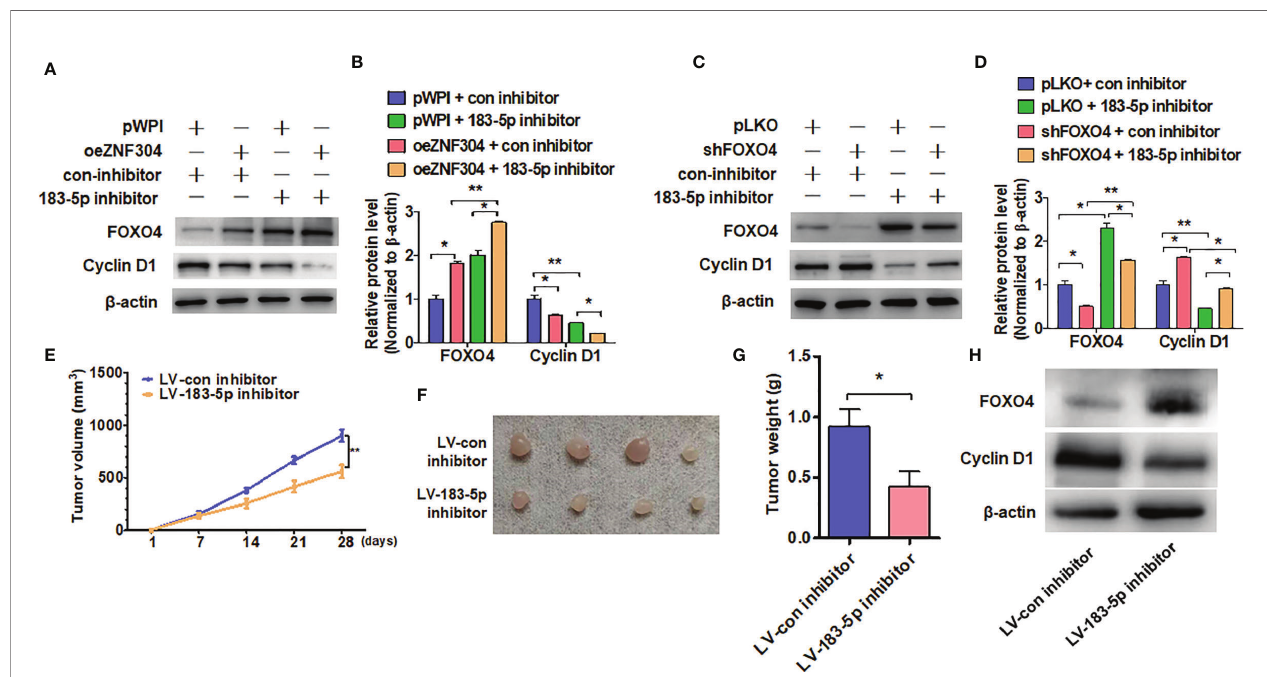
FIGURE 6 | ZNF304/miR-183-5p/FOXO4 axis inhibits ccRCC progression. (A, B) 786-0 cells were transfected with the oeZNF304, 183-5p inhibitor or co- transfected with both and then subjected to western blot analysis the FOXO4 and Cyclin D1 protein level. (C, D) Indicated RNA and vectors were used to transfect into 786-0 cells and the FOXO4 and Cyclin D1protein level were detected by Western blot. (E – G) xenograft tumors were performed by injecting 786-0 cells with stably downregulated miR-183-5p in nude mice and tumor volumes (E, F) or tumor weight (G) were measured by direct measurement. (H) FOXO4 and Cyclin D1 proteins level in xenograft tumors were examined by using western blot. All data are from three independent experiments and expressed as the mean ± SEM. *P < 0.05, **P < 0.01 vs. the corresponding